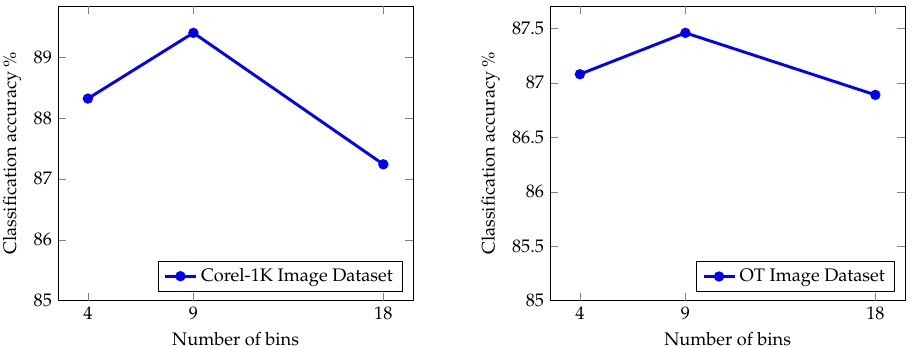
Figure 4. The influence of the number of bins on the performance of RGSIR.